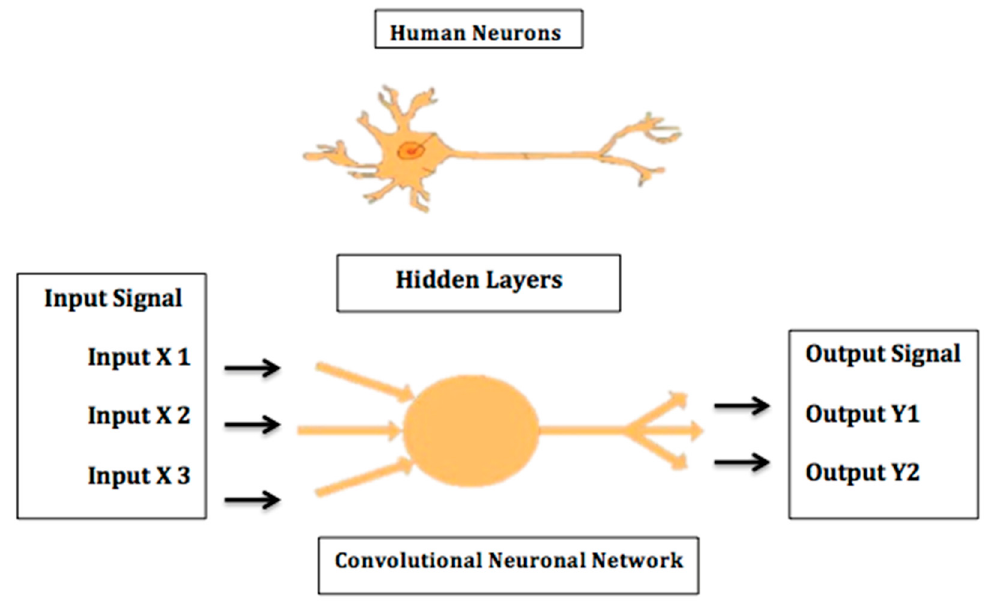
Figure 1. A neural network is a computer system modeled on the human brain.